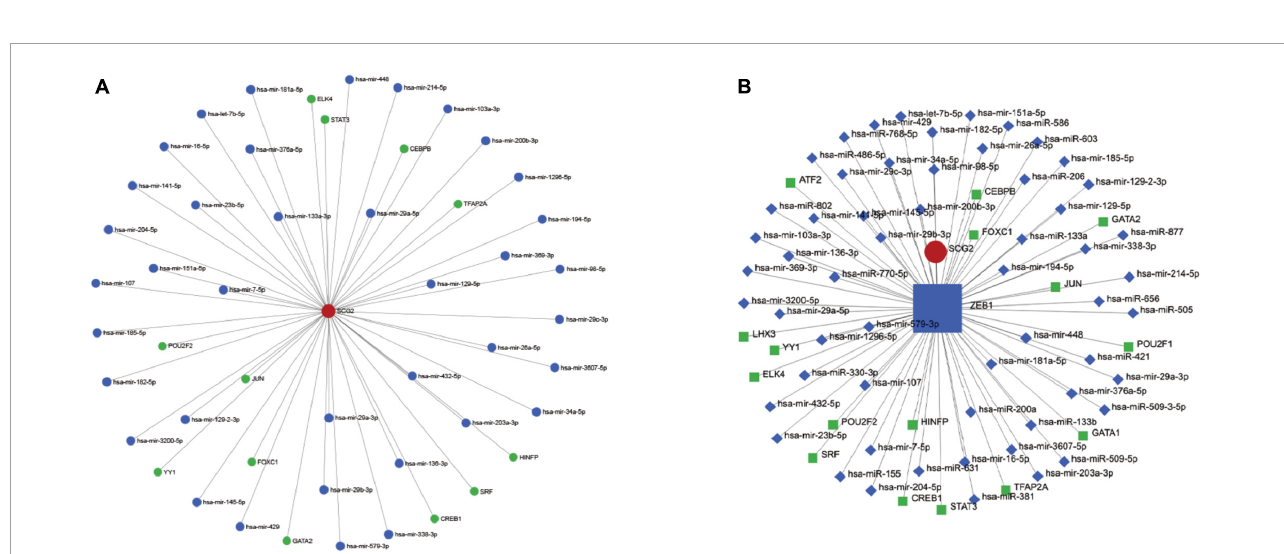
FIGURE6 (A) Upstream miRNAs and transcription factors of the key gene SCG2. (B) Interaction network diagram of the key transcription factor